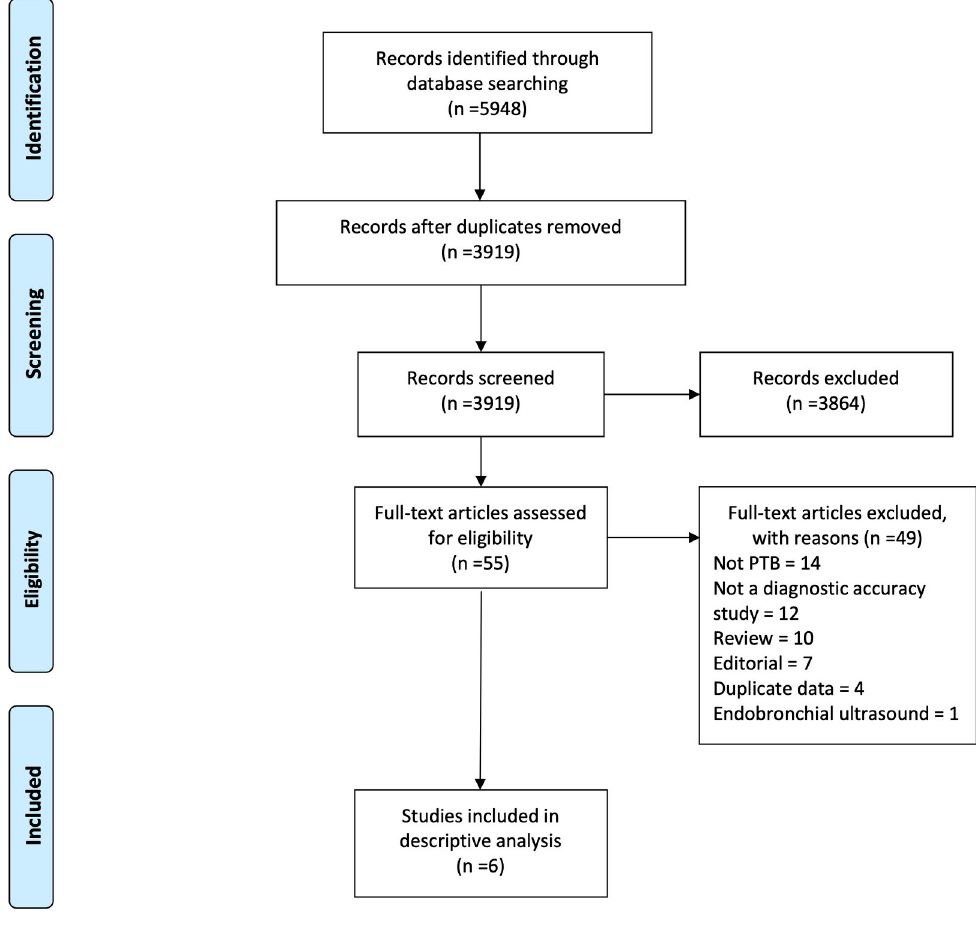
Fig 1. PRISMA study